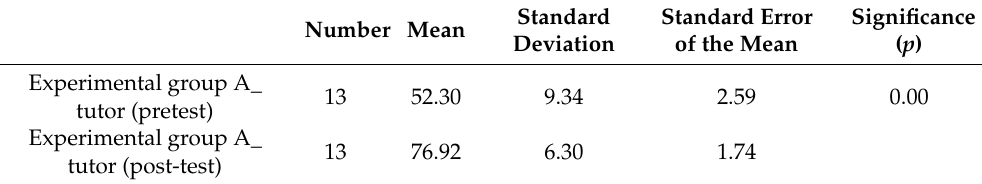
Table 5. Pretest and post-test t -test analyses of Experimental group A_tutor.